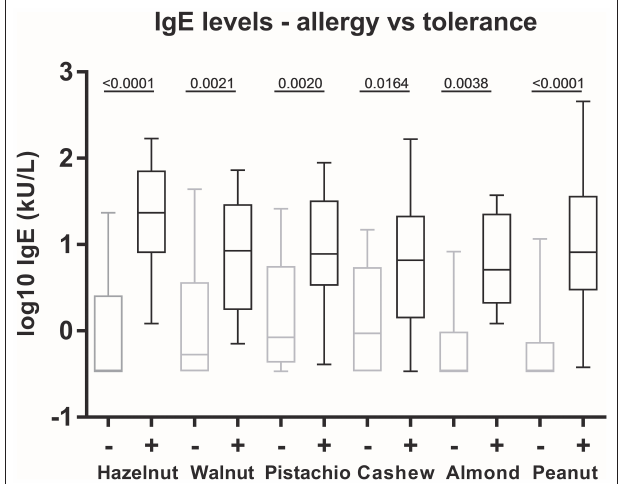
FIGURE 3 | Allergen-specific IgE levels in allergy vs. tolerance. The box plot shows the median, 25 and 75% percentiles (box), and minimum and maximum (whiskers) values of log10 values of sIgE to whole nut extracts. Statistics: One-way ANOVA followed by Bonferroni’s multiple comparison post-hoc tests. + , allergy to the nut; –, tolerance to the